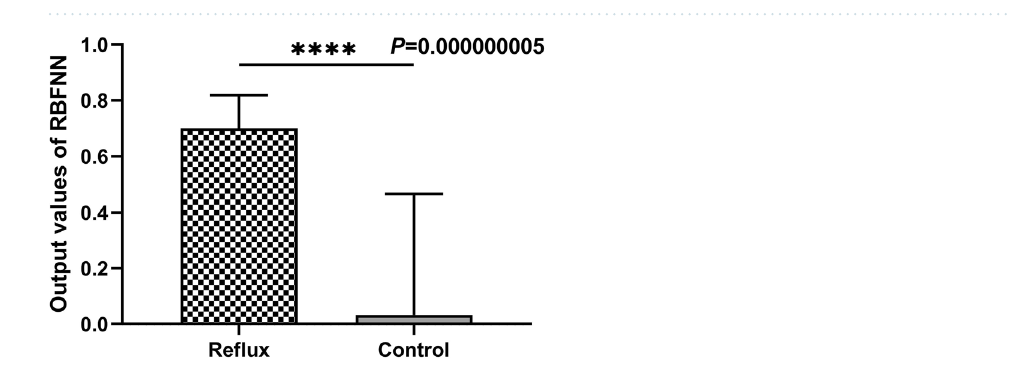
Figure 5. QFlow parameter comparison. Comparison of QFlow parameters (SV [mL], FFV [mL], ASV [mL], MF [mL/s], SD [cm], and MV [cm]) in the GSV segment for patients’ morbid and normal limbs and normal limbs of healthy controls; (*, P < 0.05; **, P < 0.01; ***, P < 0.001, unpaired two-tailed Student’s t test).